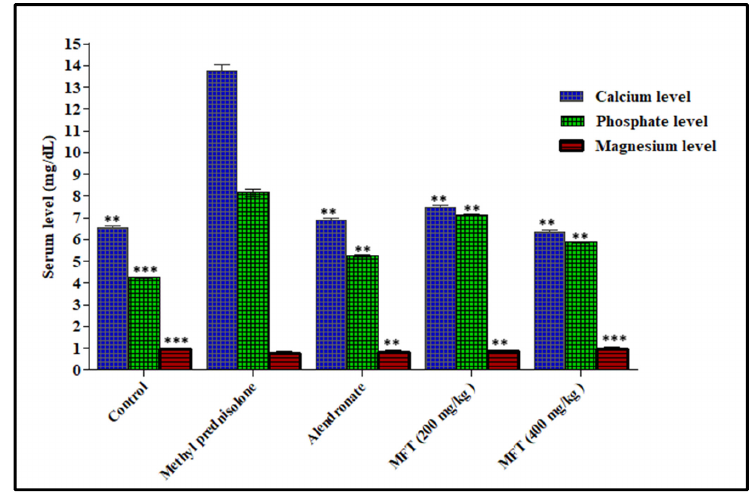
Figure 1. Effect of Matricaria chamomile Linn on serum calcium, phosphate, and magnesium levels of steroid-induced osteoporotic rat model. Values are expressed as mean ± SEM ( n = 6), where ** p < 0.01, *** p < 0.001, as compared to diseased control.